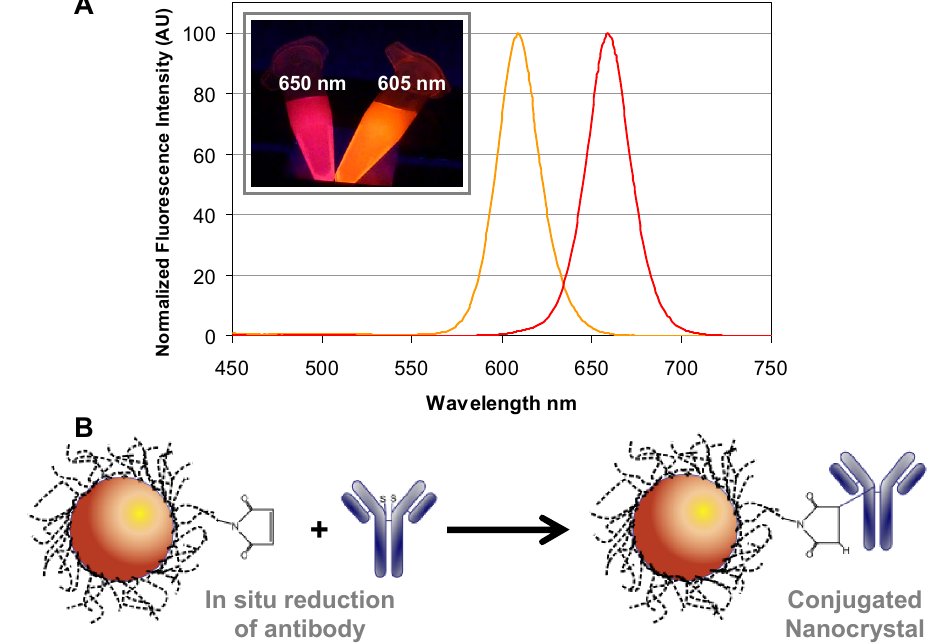
Figure 1. Sulfhydryl-reactive conjugation chemistry. (A) Photoluminescence spectra for eFluor® NC605 and NC650 used in this study, Ex@400 nm, the insert shows a